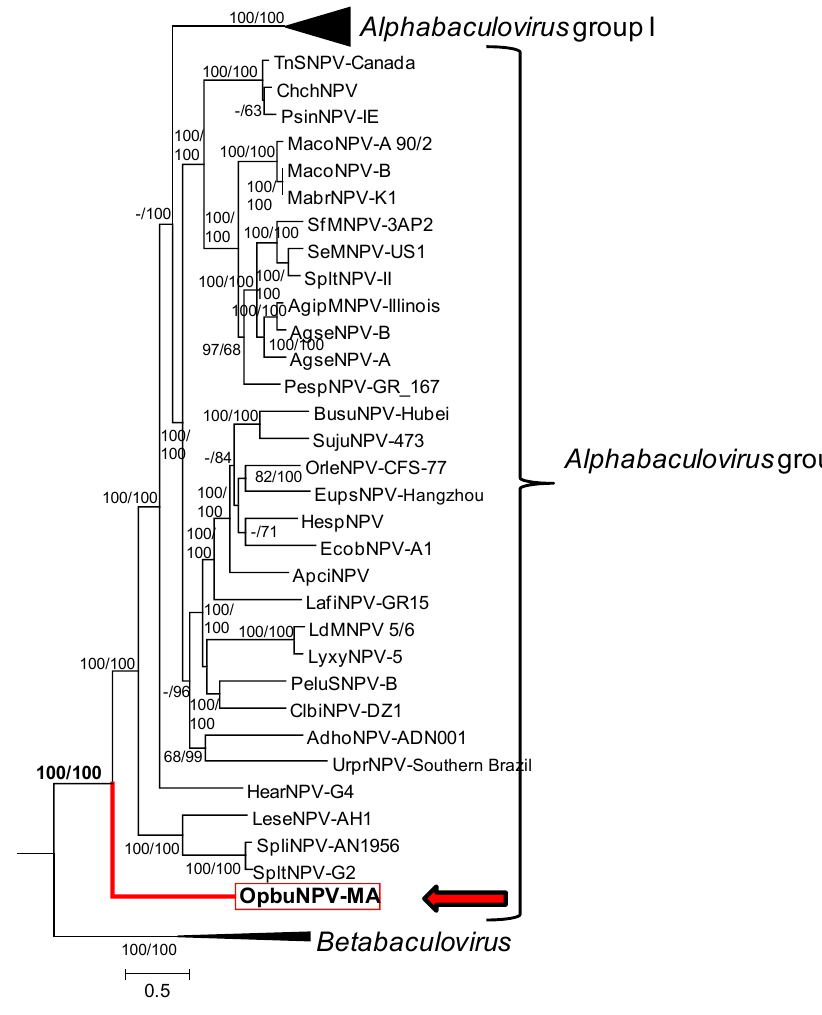
Figure 10. Relationships of OpbuNPV-MA and representative isolates of other baculovirus species, inferred from the predicted amino acid sequences of baculovirus core genes. The ML phylogram was constructed from the concatenated alignments of 38 baculovirus core gene amino acid sequences using the ME method. Shown is a subtree of a tree that also included viruses of the genera Gammabaculovirus and Deltabaculovirus. Branches for betabaculoviruses and the group I alphabaculoviruses are collapsed, and the numbers of taxa in those nodes are shown in parentheses. Group II alphabaculoviruses are indicated with brackets. Bootstrap values >50% for both ME and ML analysis are indicated for each interior branch (ME/ML). OpbuNPV-MA is indicated with a red arrow, red branch, and red box surrounding the taxon. The taxa and sequences used in the analysis are as listed in Table S1.